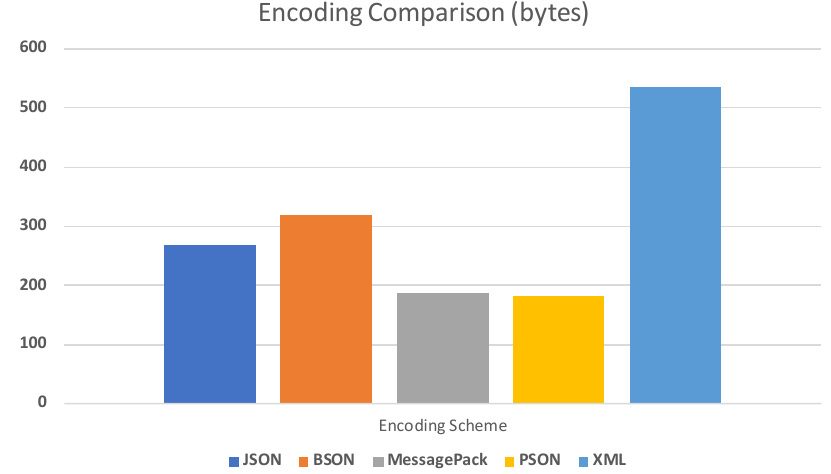
Figure 2. Encoding size comparison between different formats. Thinger.io uses a PSON encoding scheme to improve memory footprint, save bandwidth, and reduce power consumption in